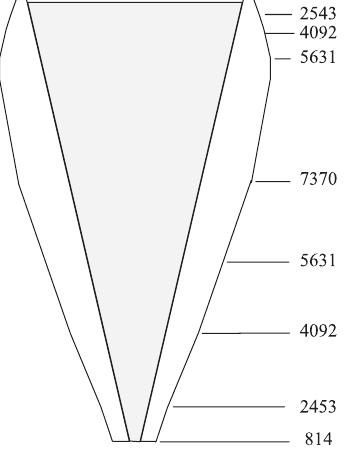
Fig. 6 The contact friction zone and the node location. Fig. 7 The contact friction stress (Pa).